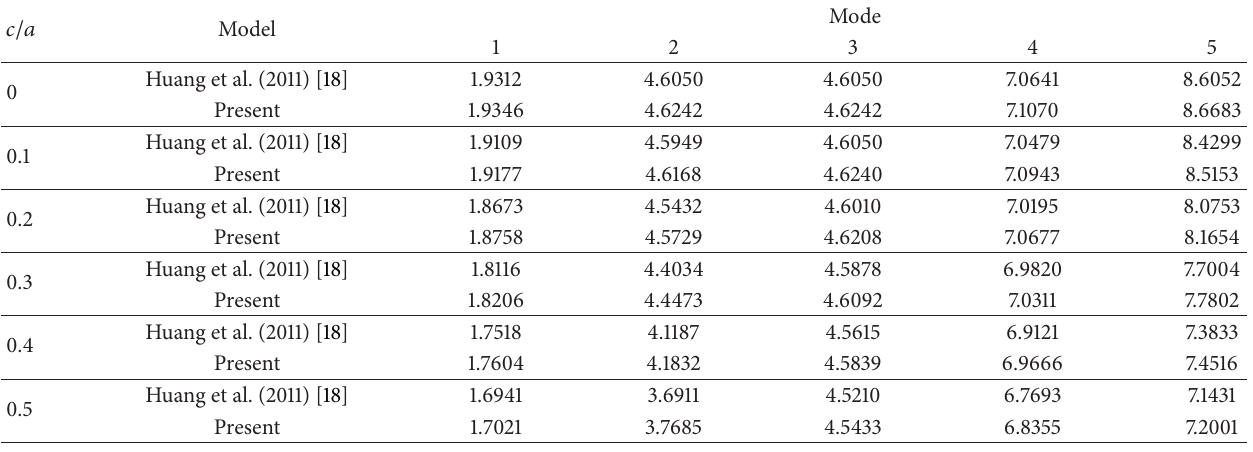
Table 1: Comparison of nondimensional frequencies with respect to variation of crack lengths.